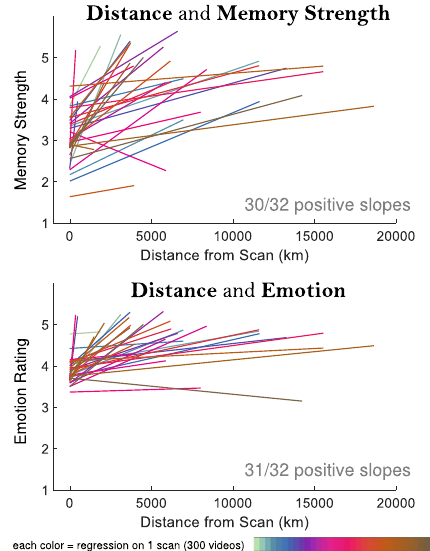
Fig. 3 | Relationships across memory qualities. Each plot shows regression fi t lines (intercept and slope) for all 32 samples for four comparisons: (top left) memoryageandstrength,(topright)memorydistanceandstrength,(bottomleft) memoryageandemotionrating,and(bottomright)memorydistanceandemotion rating. These trends are shown for illustrative purposes and are statistically con- fi rmed by Spearman rank correlations in the main text that make no assumption about linearity. Memory strength ratings ranged from 1 (very weak) to 5 (very strong),while emotionratingsranged from 1 (verynegative)to 5(verypositive).In 28 out of 32 participant samples, age had a negative relationship with memory